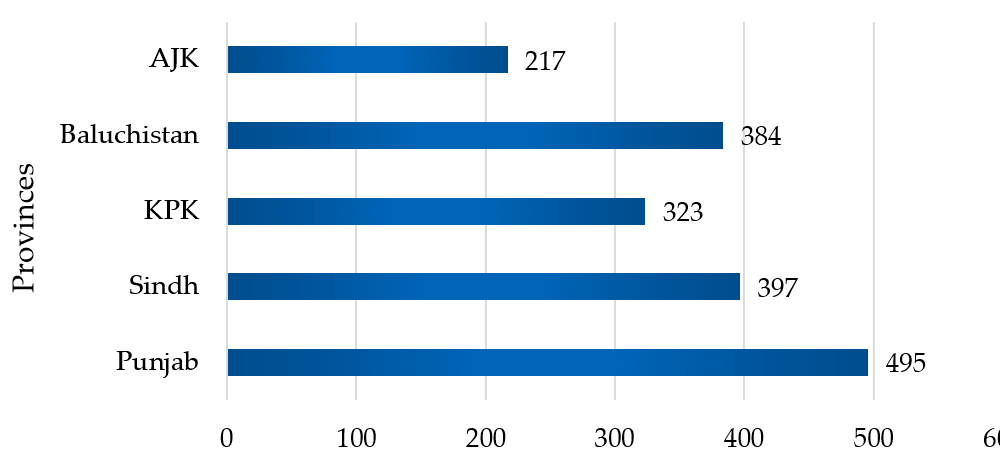
Figure 9. ECPC of Pakistan province-wise [32].